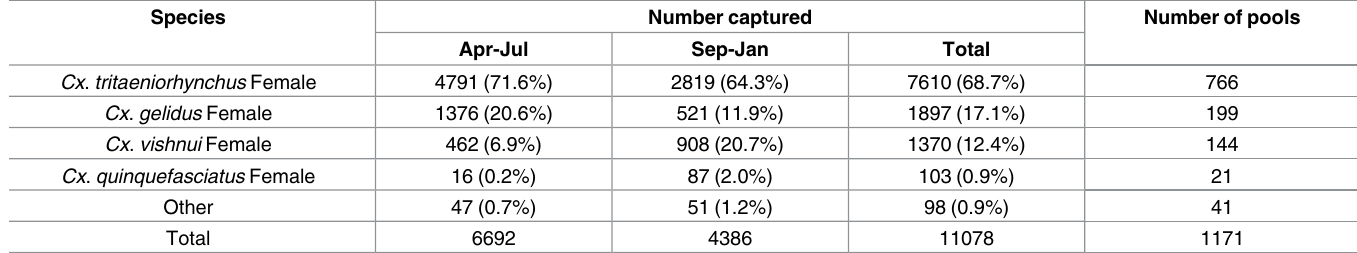
Table 1. Summaryof the number of mosquitoes captured per species.